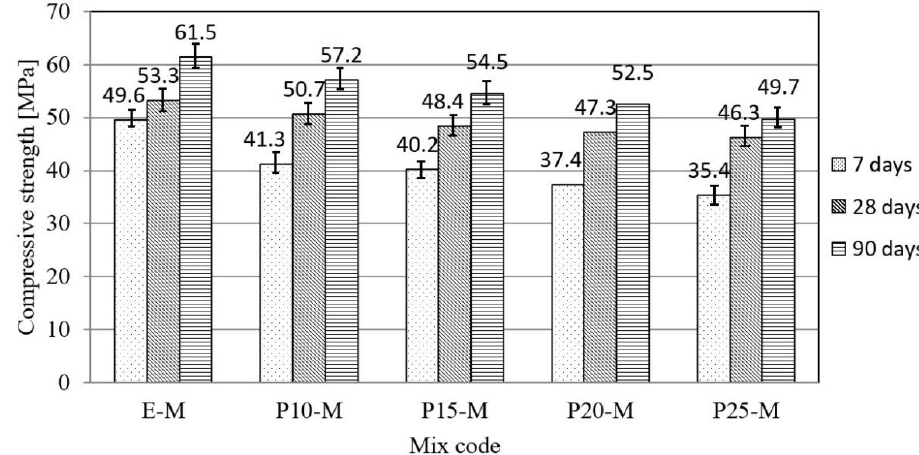
Figure 1. Flexural strength of mortar mixtures.